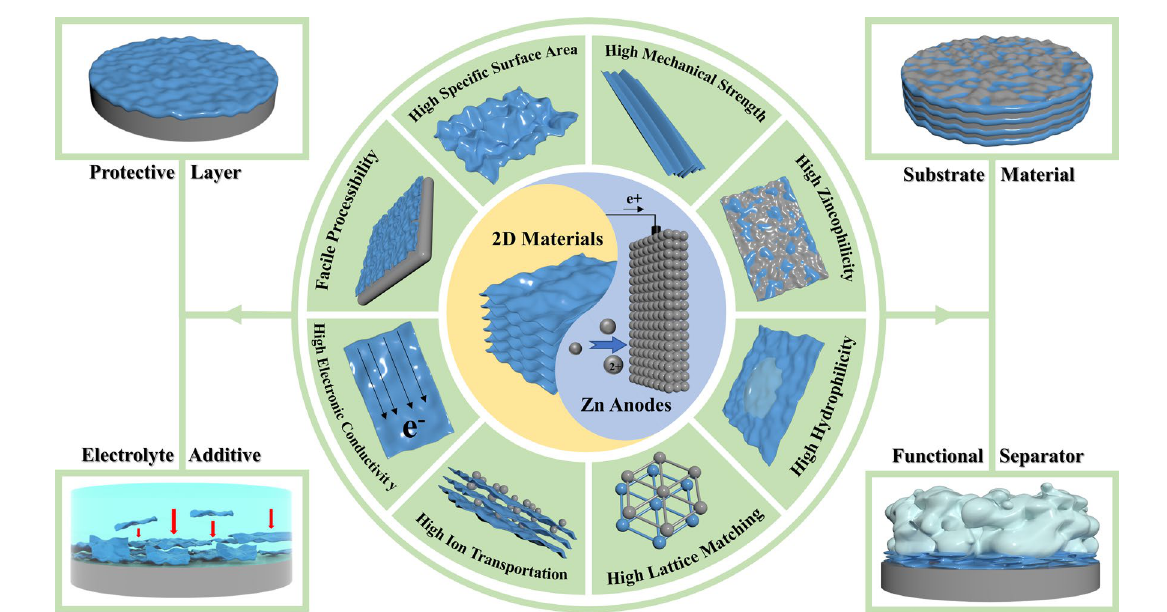
Fig. 1 Overall schematic diagram of harnessing the unique properties of 2D material toward advanced Zn anodes for high-performance